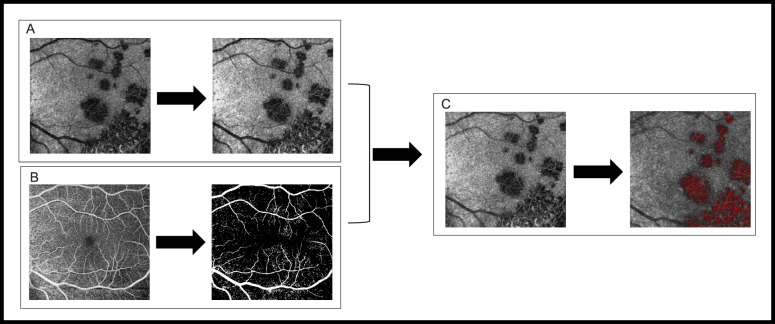
Shows the steps by which an investigator-generated algorithm calculates CC FV. All image slabs were generated by automated segmentation from Angioplex OCTA software on a Zeiss Cirrus HD-OCT Model 5000 device. (A) This panel shows the choriocapillaris slab before and after image standardization via brightness histogram contrast stretching. (B) This panel shows the SCP slab before and after binarization. (C) The final images in panels A and B are overlaid to remove projection artifacts and generate the first image in panel C. The choriocapillaris image then undergoes alignment and cropping, followed by FV quantification using the pixel intensity of the avascular slab as a threshold for measurement. All pixels with intensities at or below the defined threshold are highlighted in red and quantified as shown in panel C. It is important to note that binarization and projection artifact removal do not visually remove shadows generated on the choriocapillaris by the overlying SCP.